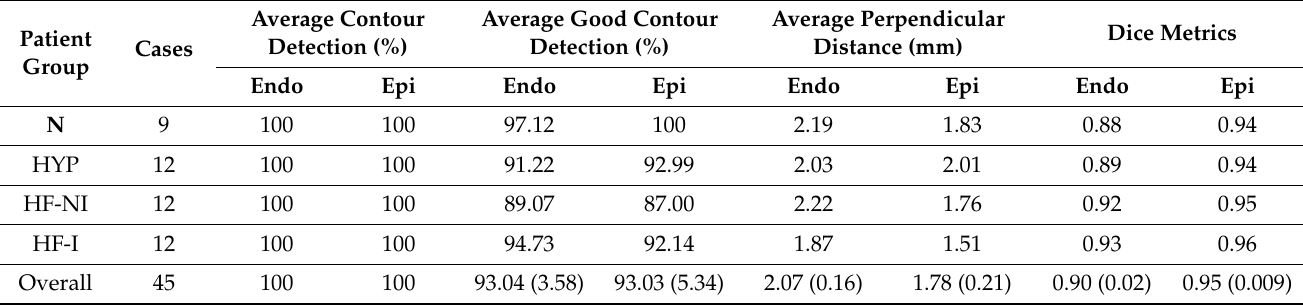
Table 14. Performance evaluation parameters for binary cross-entropy loss and Relu activation.